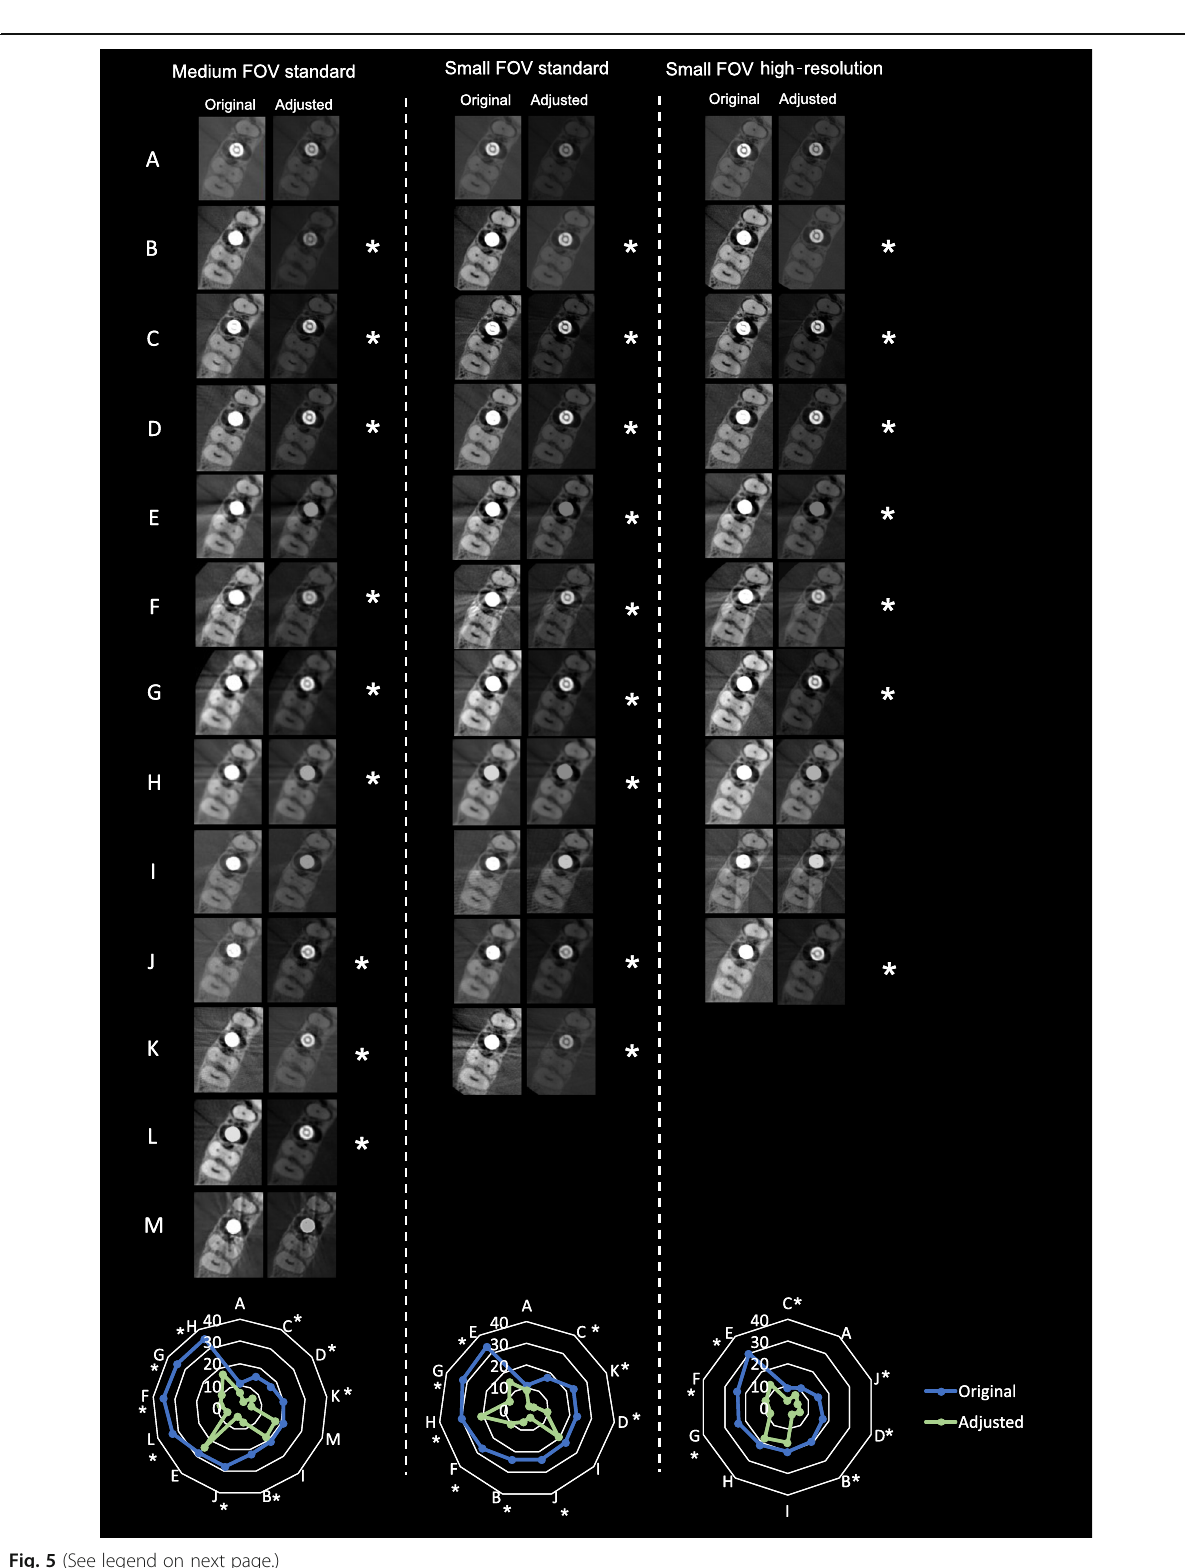
Fig. 5 (See legend on next